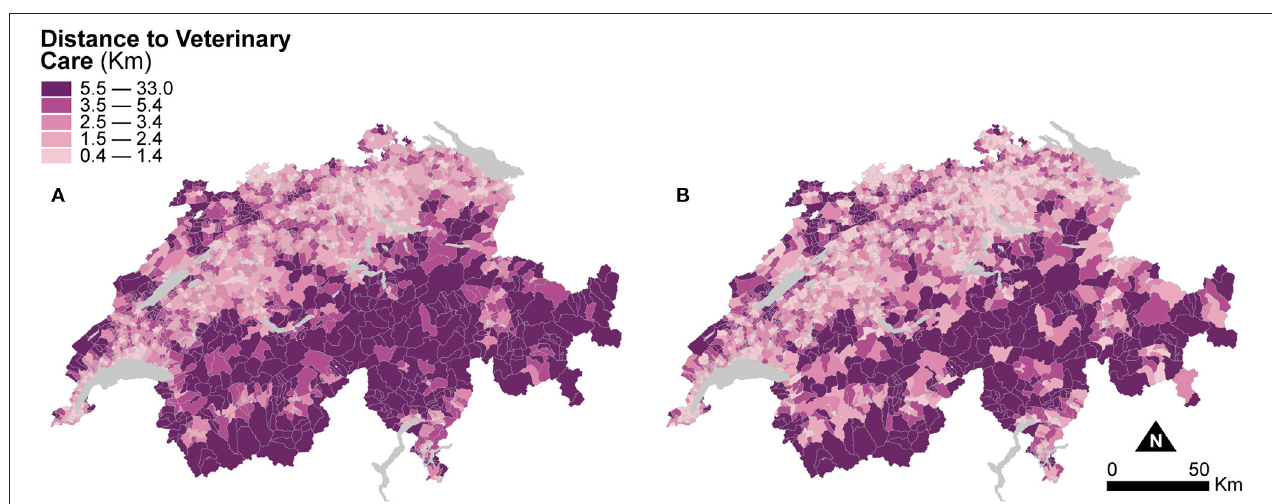
FIGURE 4 | Distance to veterinary care indicators resulting from the two enumeration types — (A) municipal units and (B) dasymetrically refined units. For better visual comparison, the indicator recomputed after dasymetric refinement is also presented in a choropleth fashion. The data is classified according to the quantile classification method applied to the dasymetrically refined